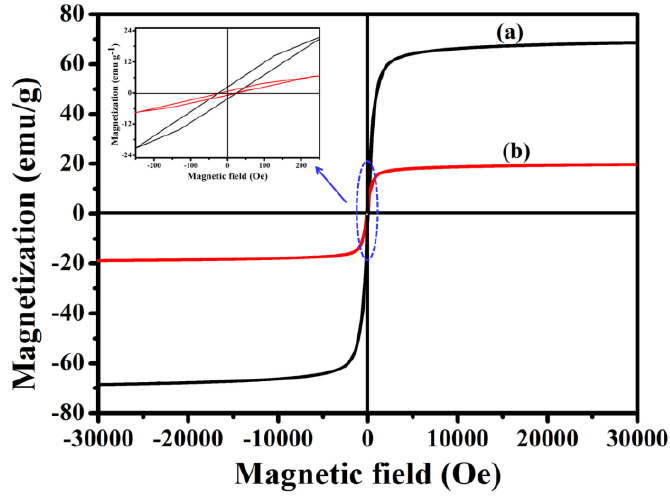
Figure 7. Magnetic measurements of ( a ) Fe 3 O 4 and ( b ) Fe 3 O 4 @1.